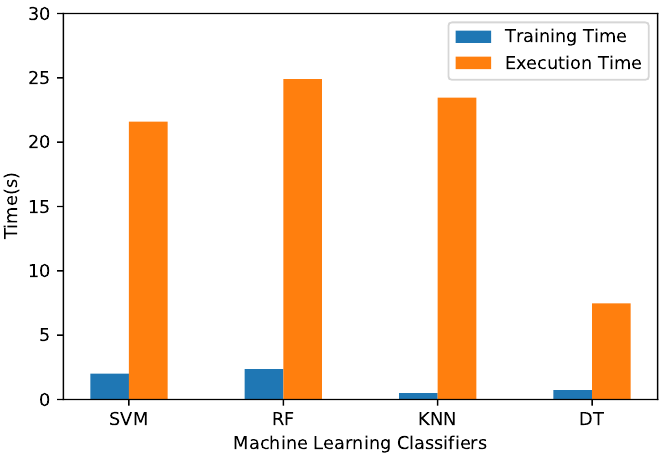
Figure 9. Training and execution times of machine learning